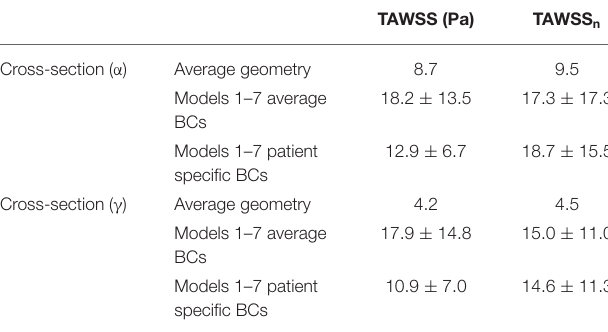
TABLE 5 | Averaged TAWSS, derivd from the TAWSS values of eight points located along the perimeter of cross-sections ( α ) and ( γ ), are presented both in Pascal (Pa) and non-dimensionalized